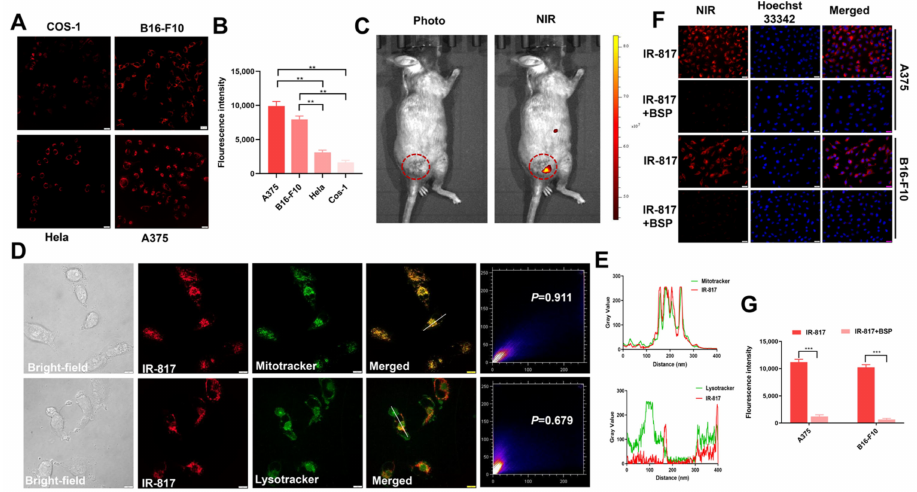
Figure 2. Study on the specific targeting effect of IR-817 in vitro and in vivo. ( A ) Fluorescence image of 5 µ M IR-817 co-incubated with Hela, A375, B16-F10, and COS-1 cells for 1 h. Scale bars, 20 µ m. ( B ) The fluorescence intensity quantification of IR-817 in Hela, A375, B16-F10, and COS-1 cells (mean ± SD, n = 3). ( C ) In vivo imaging of the subcutaneous tumor mice model after tail vein injection 5 mg/kg IR-817 for 12 h. ( D ) Fluorescence co-localization of IR-817 and Mitotracker Green or Lysotracker Green in A375 cells. Scale bars, 10 µ m. ( E ) Normalized intensity profiles of the co-localized image along the pixels marked by the solid line. ( F ) Fluorescence image of 5 µ M IR-817 incubated with or without BSP-treated A375 and B16-F10 cells for 1 h. Scale bars, 100 µ m. ( G ) The fluorescence intensity quantification of IR-817 in different conditions (mean ± SD, n = 3). *** p < 0.001, ** p < 0.01, compared with